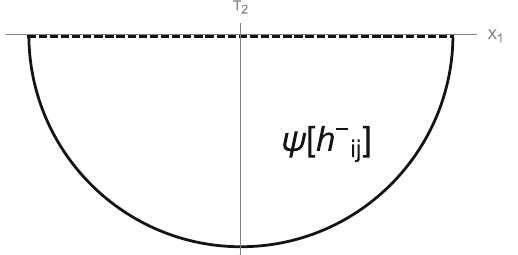
Fig. 2 Geometric representation of the BH state defined on the T 1 = 0